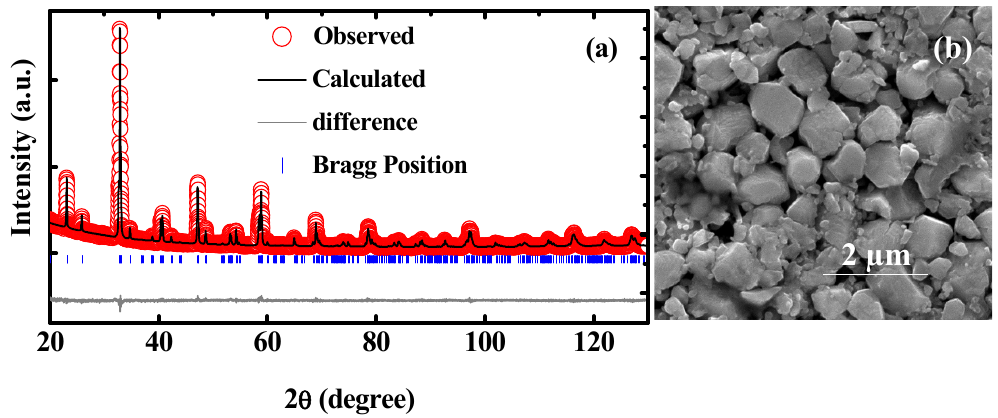
Figure 1. (Color online) ( a ) Rietveld refinement result of the XRD pattern, ( b ) FESEM morphology of the NdCrO 3